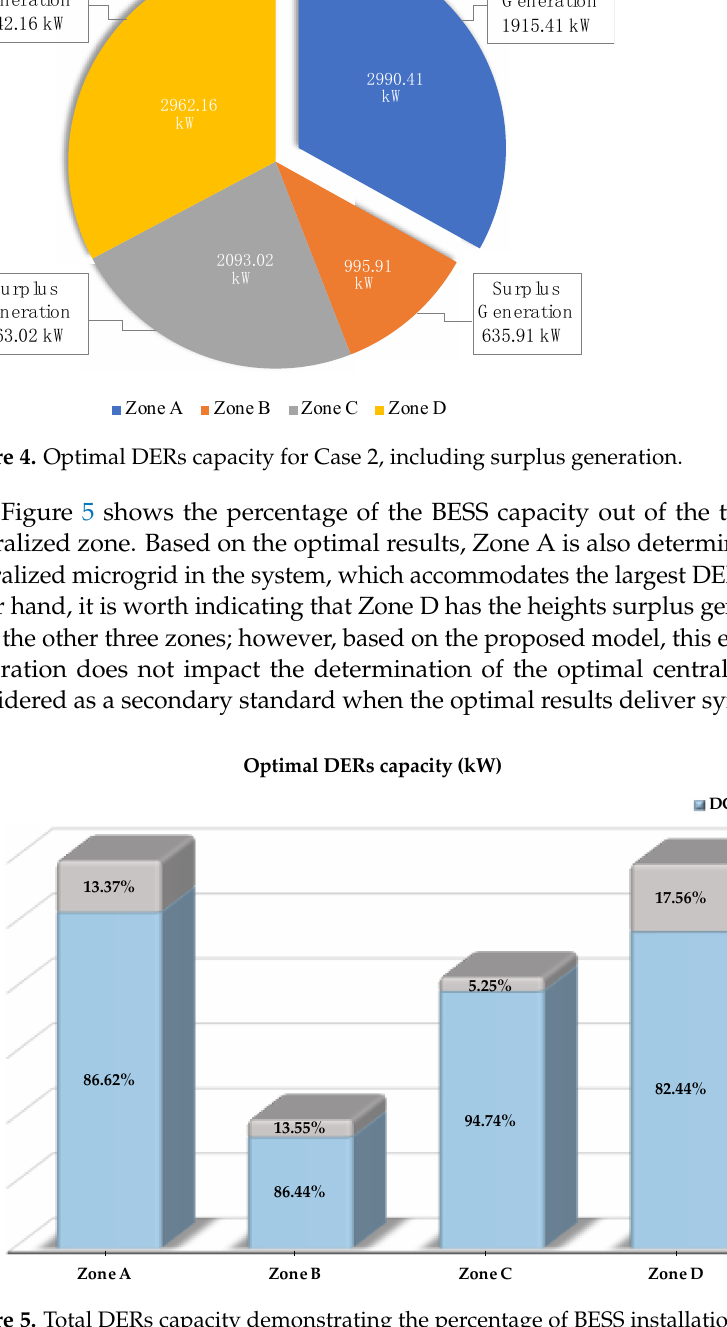
Figure 5. Total DERs capacity demonstrating the percentage of BESS installation.